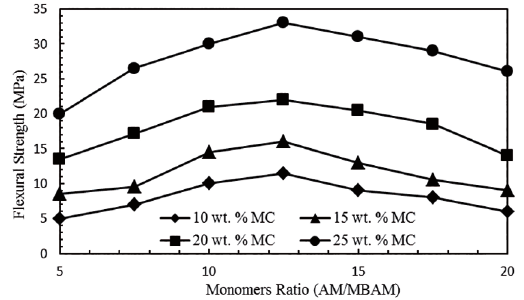
Figure 10: Dependence of the strength of green gelcast TiC on the monomer content as a function of monomer ratio for the 40 vol.% solid loading.